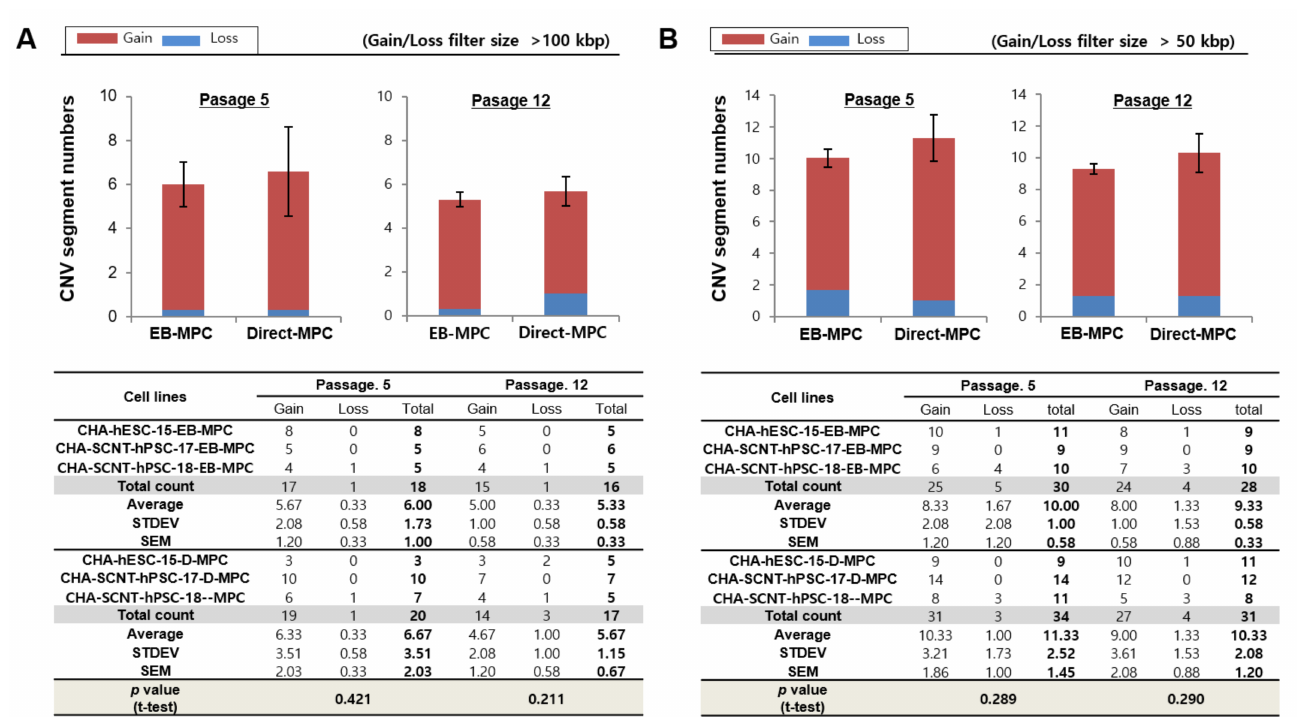
Figure 4. Array-based comparative genomic hybridization analysis of hPSC-derived EB-MPCs and Direct-MPCs at an early passage (5) and late passage (12). Human PSCs were used as the control cells in the genomic variation analysis by array-CGH. The CNV results are presented as the means for MPCs derived from three cell lines: CHA-hESC-15, CHA-SCNT-hPSC-17, or CHA-SCNT-hPSC-18. The data are presented as the means ± SE. ( A ) Variation size >100 kbp, ( B ) variation size >50 kbp.